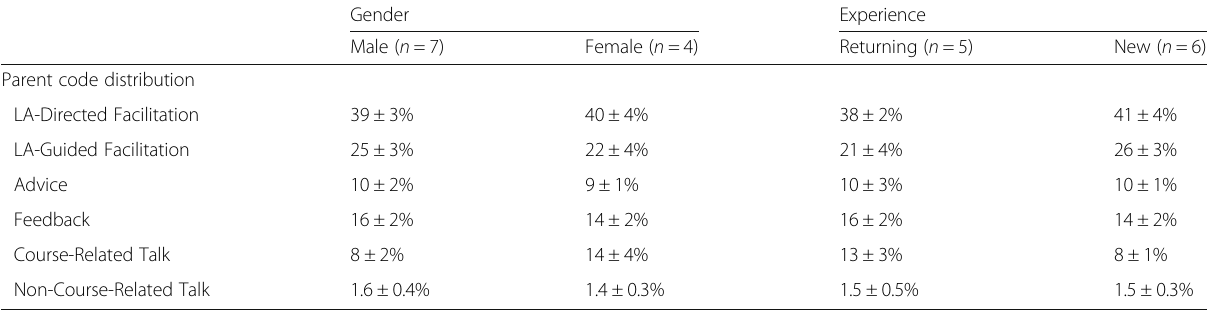
Table 4 Comparison between LAs by gender and previous LA experience. n is number of LAs. Values take into account the total parent codes recorded for each LA before averaging across LAs. Values are mean ± SEM